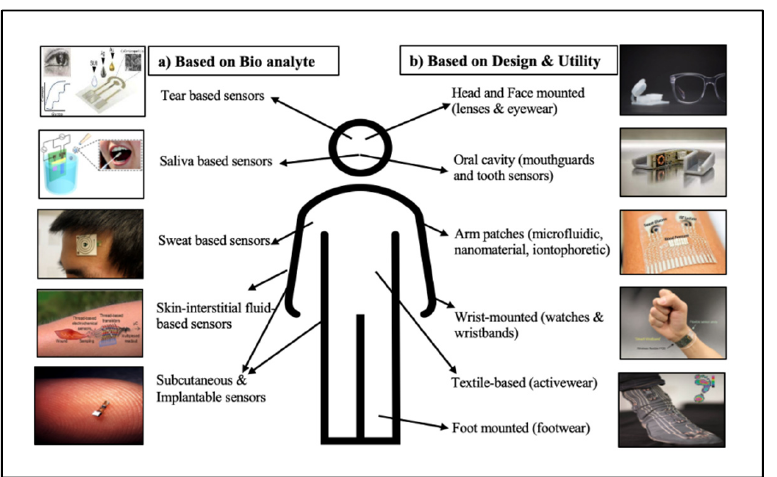
Figure 2. Different types of wearable devices categorized based on ( a ) bio-analyte and ( b ) design and utility. Images courtesy of [21–25], Reprinted with permission from [26] Copyright (2018), Else- vier [27,28], Reprinted with permission from [29]. Copyright (2019), American Chemical Society [30].